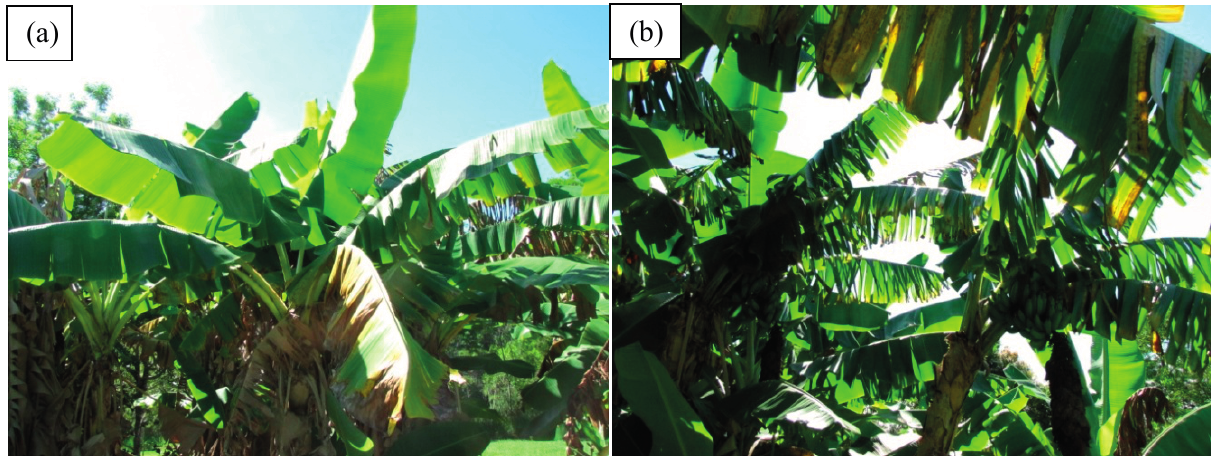
Figure 3. ( a ) Sunlit and shaded banana plant leaves; and ( b ) torn banana plant